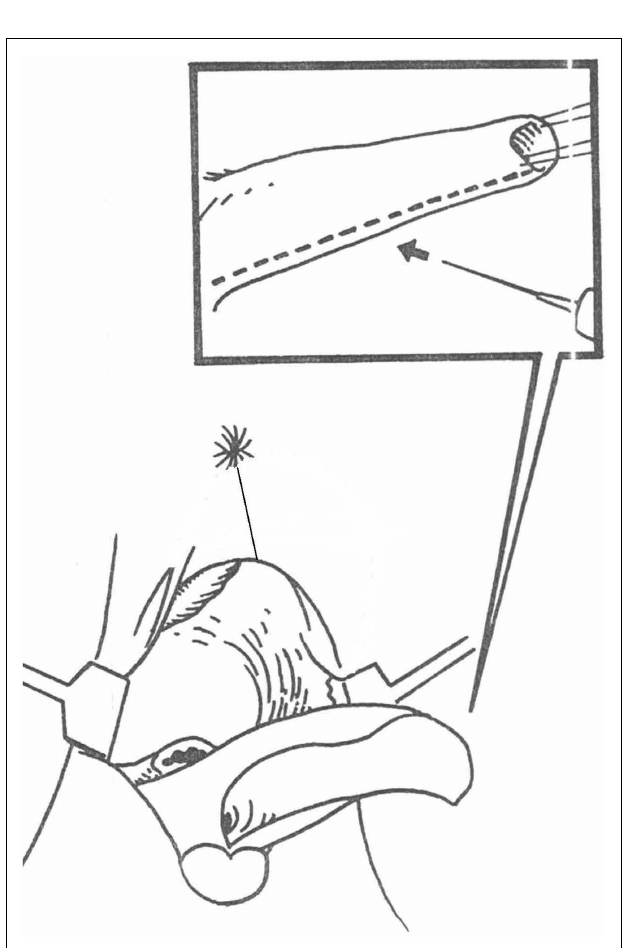
FIGURE 7 | Diagram of the UGS transected ventrally (patient is in prone position) and everted to reach the anterior wall of the vagina . In this way, the proximal part of it stays as